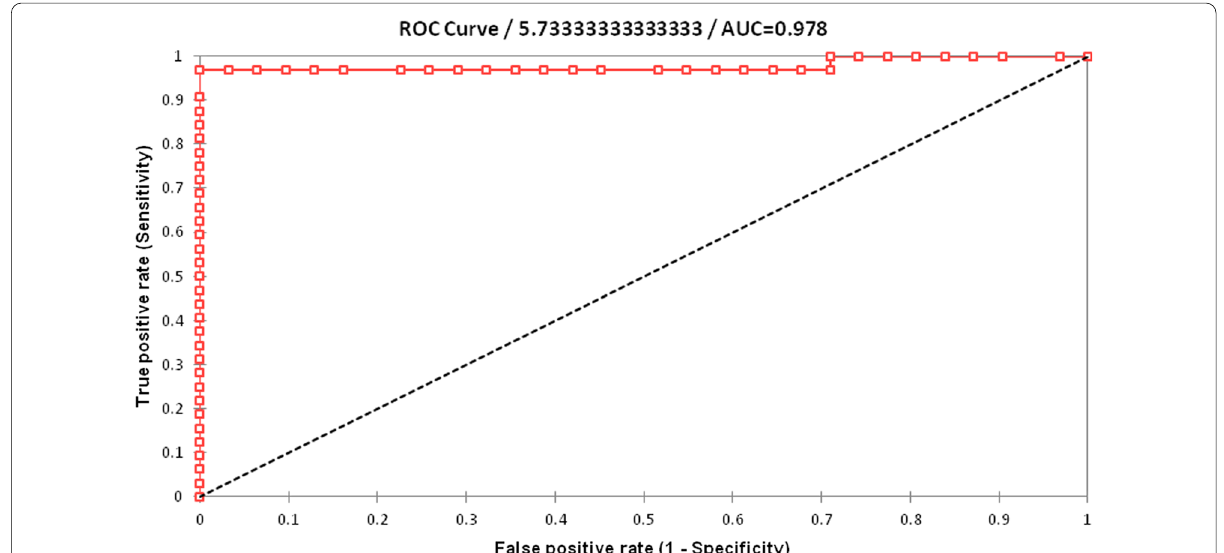
Fig. 7 ROC curve showing the optimal SWE cutoff value for autoimmune thyroiditis